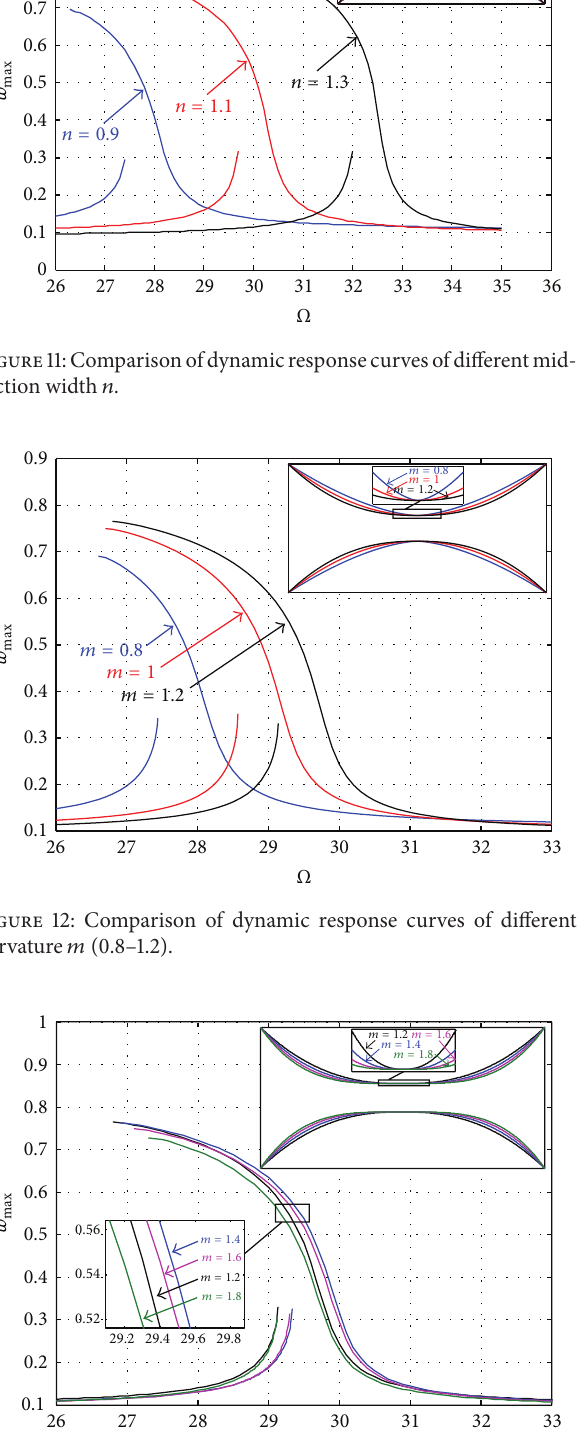
Figure 13: Comparison of dynamic response curves of different curvature 𝑚